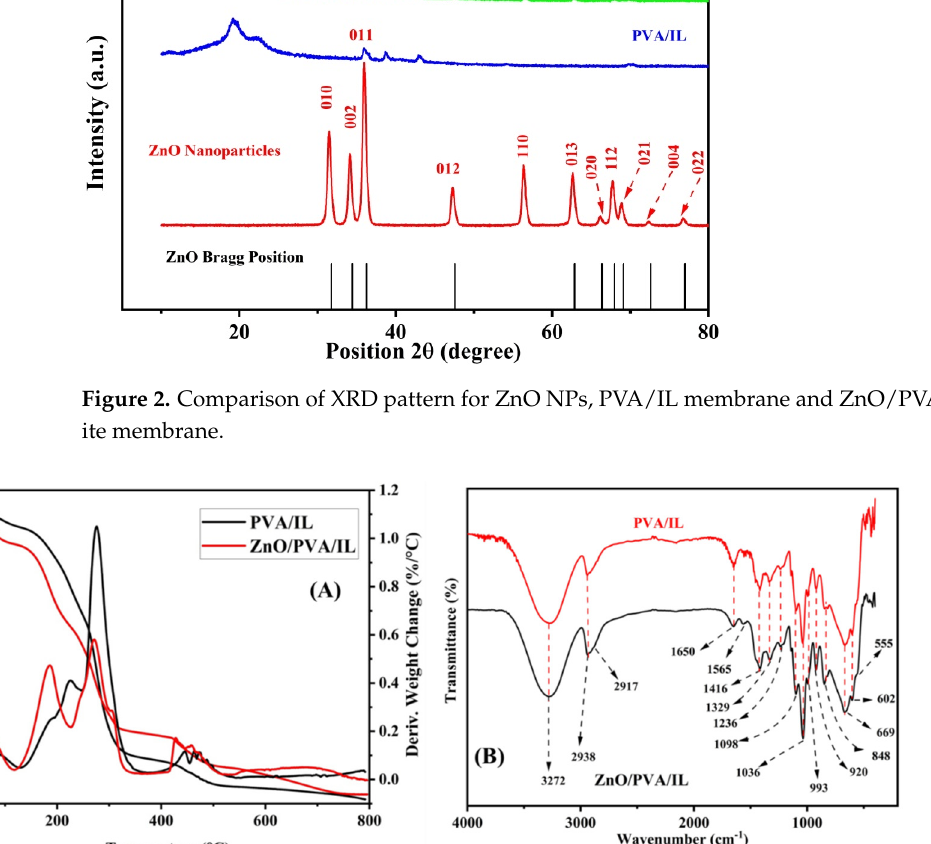
Figure 2. Comparison of XRD pattern for ZnO NPs, PVA/IL membrane and ZnO/PVA/IL composite membrane.